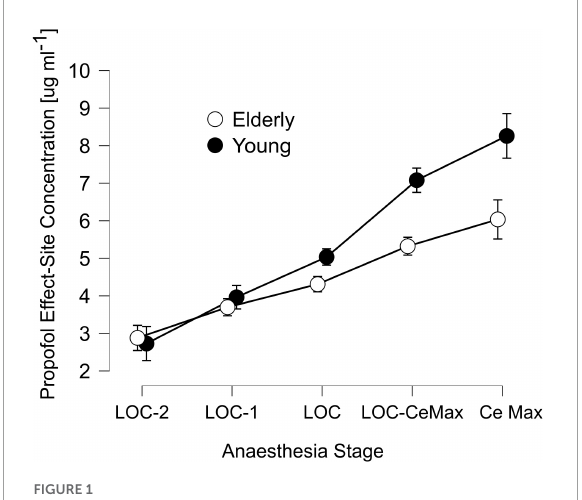
FIGURE1 Schnider’s Effect-site propofol concentrations across anesthesia stages: 2 min before loss of consciousness (LOC) (LOC-2), 1 min before LOC (LOC-1), LOC, the midpoint between LOC and the maximal propofol concentration at the effect-site accordingly to Schnider’s model (LOC-CeMax) and the point of maximal effect-site concentration (CeMax), for elderly (unfilled circles) and young patients (filled circles). Error bars represent the 95% confidence